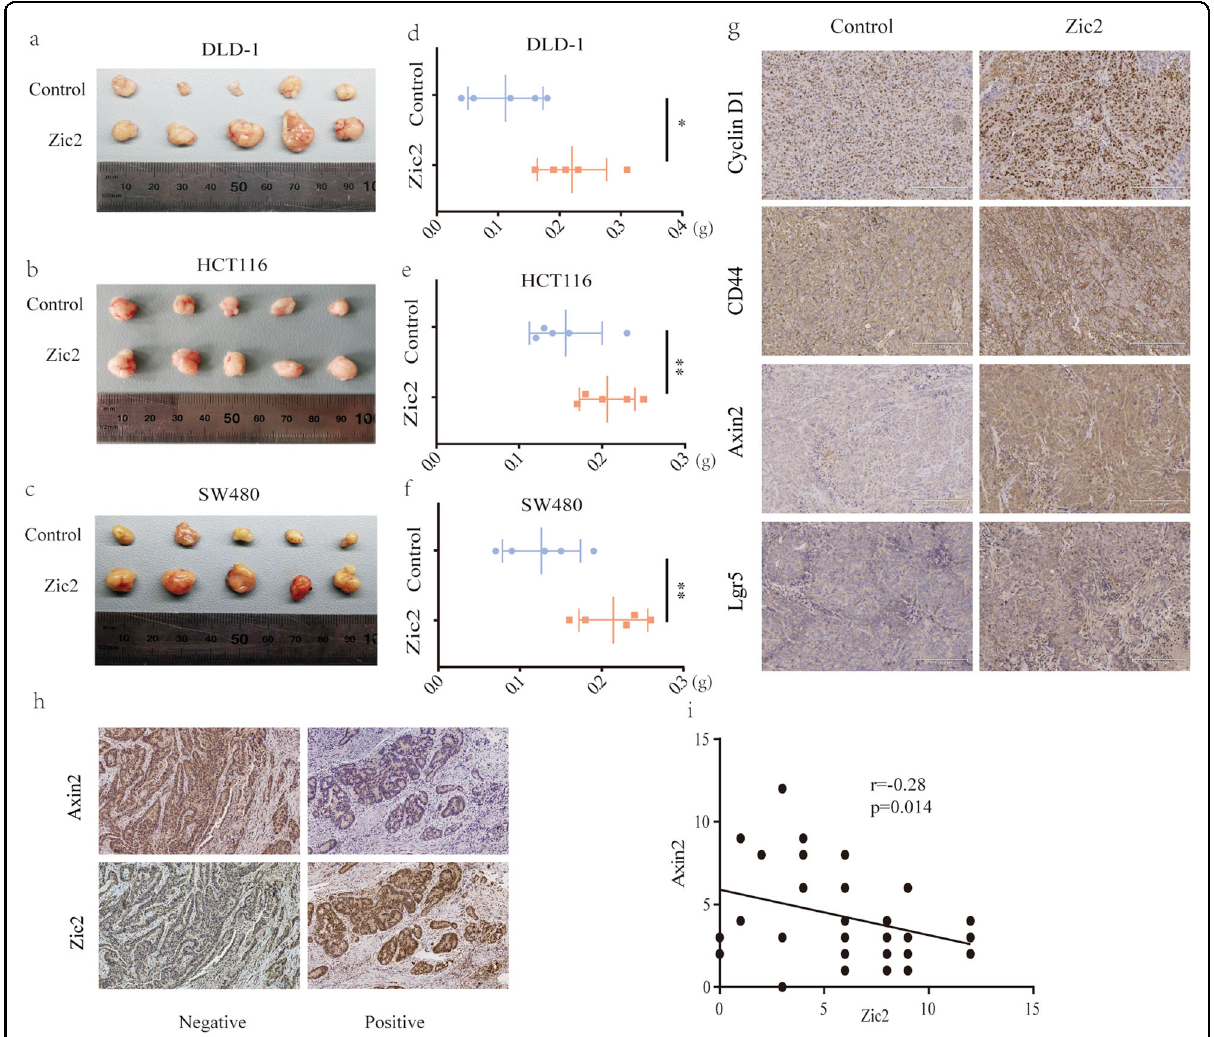
Fig. 7 Correlation between Zic2 and Wnt signaling in vivo. a – c Images of xenografts 21 days after inoculation of cell liners transfected with Zic2 or the vector. d – f Weight of xenografts at 21 days after inoculation of cell liners transfected with Zic2 or the vector. g Immunohistochemistry for CD44, Cyclin D1, Axin2, and Lgr5 in DLD-1 transfected with Zic2 or the vector. h Representative images of immunohistochemical staining showing the Zic2, Axin2 expression in CRC tissues. i Correlation between IHC staining scores of the Zic2 and Axin2 in 42 colon cancer tissues. All data are presented as the mean ± SD from three independent experiments. * P < 0.05, ** P <